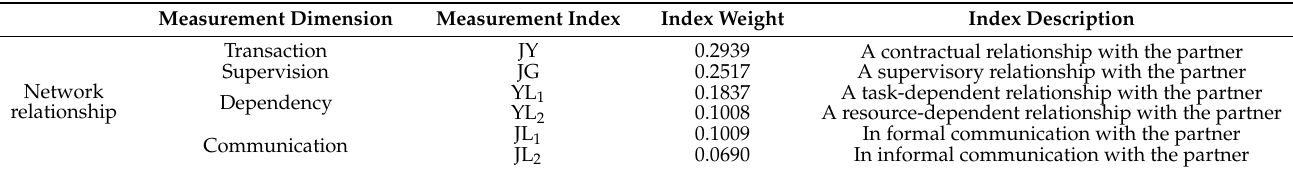
Table 3. Measurement index of the network relationships among